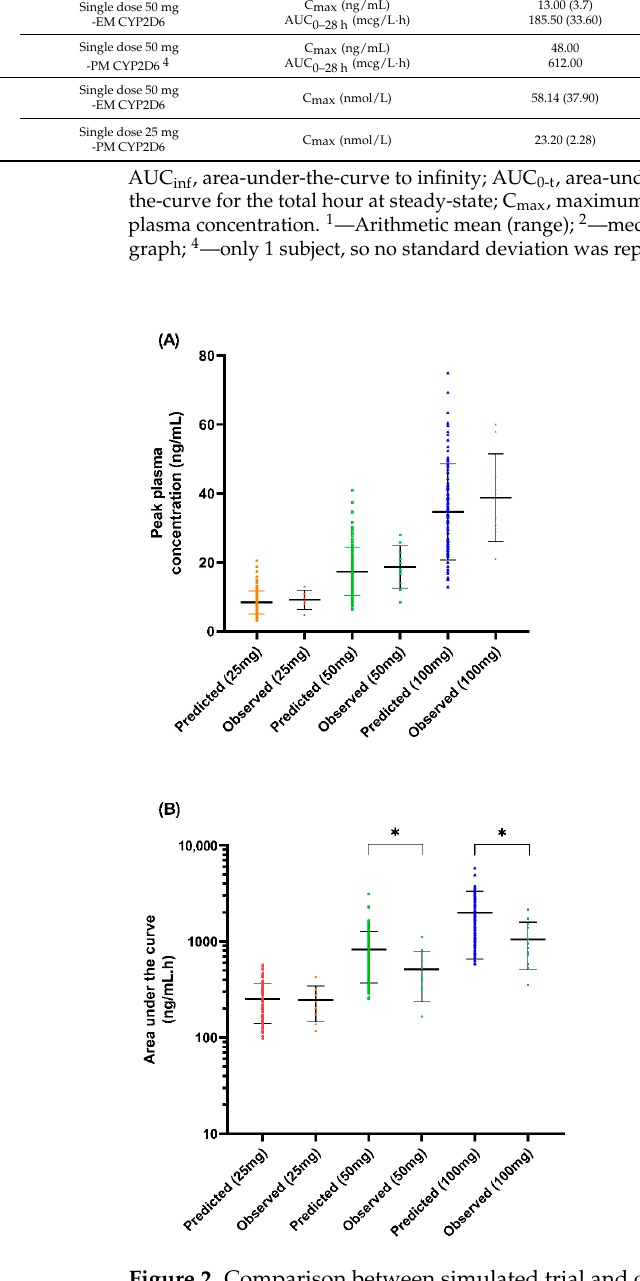
Figure 2. Comparison between simulated trial and observed data for ( A ) C max and ( B ) AUC inf from De Vries et al. [39]. Coloured data points arranged vertically represent the predicted and observed data for each dose; horizontal lines on the coloured data points represent the mean and standard deviation (SD). * p < 0.05.